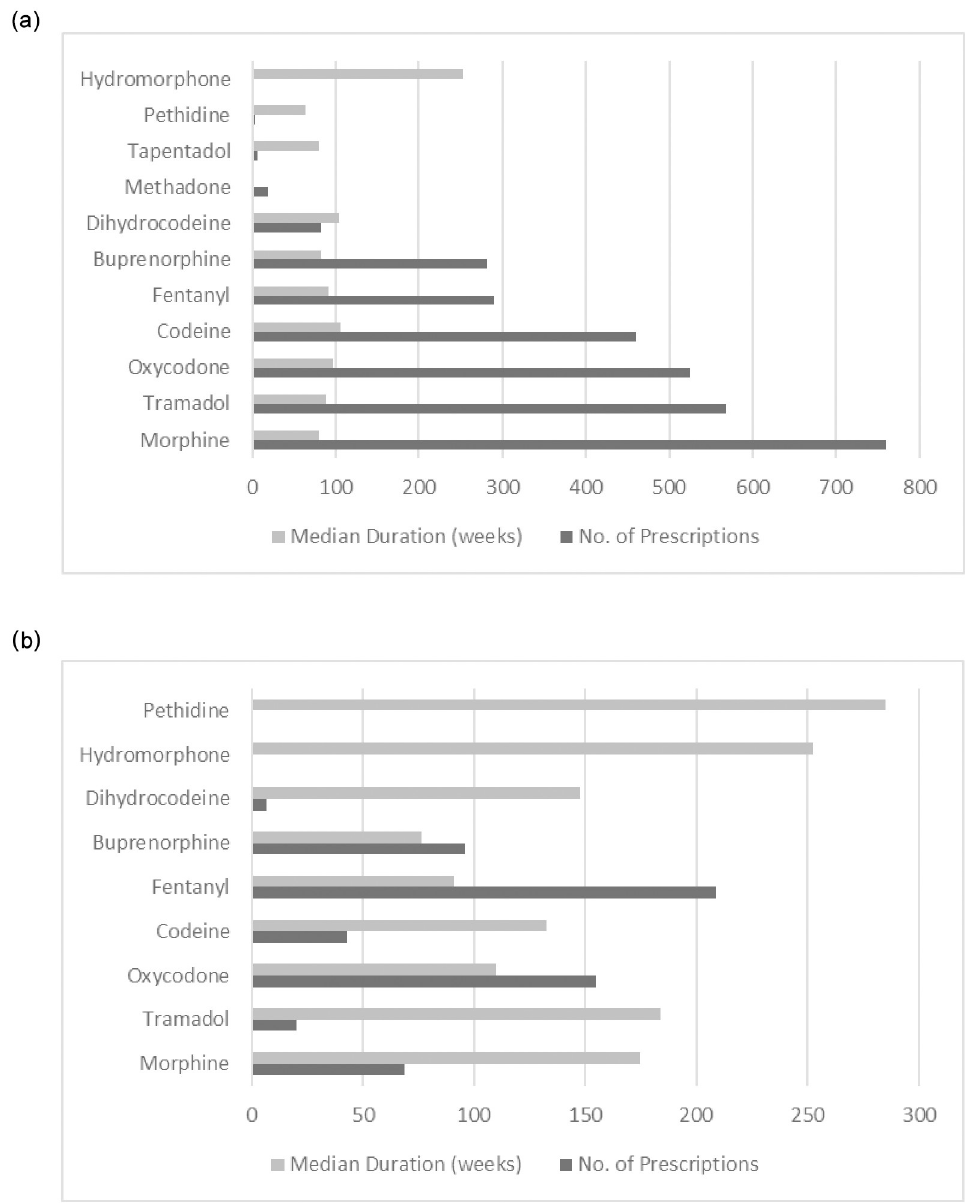
Fig 2. Average (Median) length of prescribing, and number of prescriptions for opioids commonly contributing to: a) Total MED doses > 120mg/day. B) Average MED doses > 120mg/day.